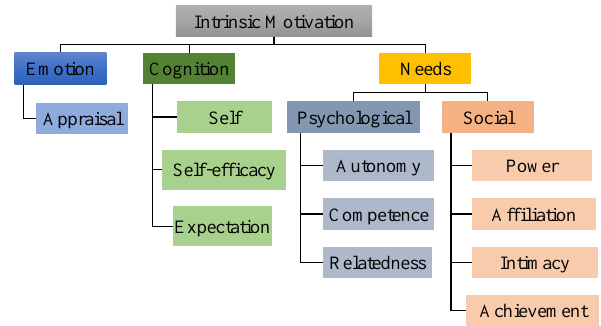
Figure 1. Conceptual schema to motivation (adapted from Piccolo & Ba- ranauskas